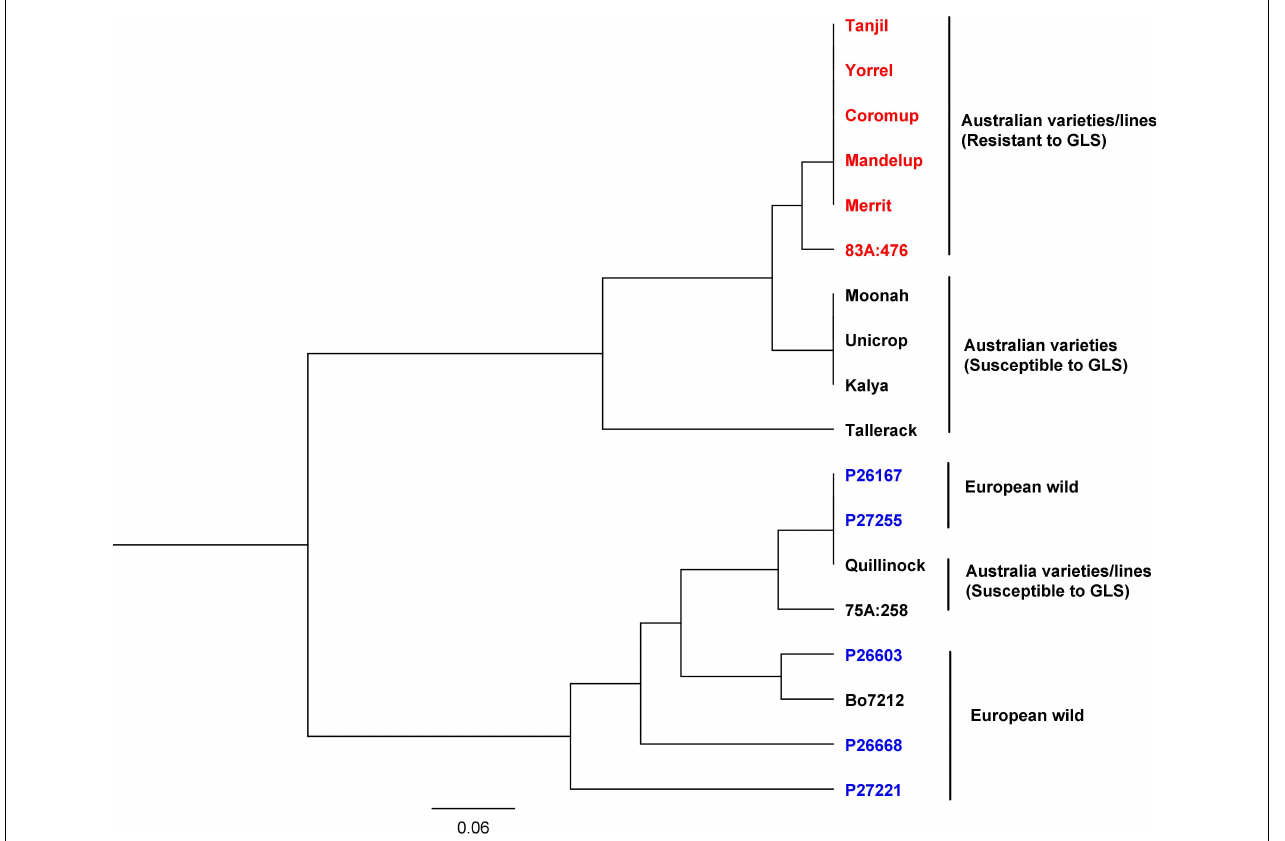
FIGURE 6 | Phylogenetic tree of gray leaf spot candidate gene from 18 narrow-leafed lupin